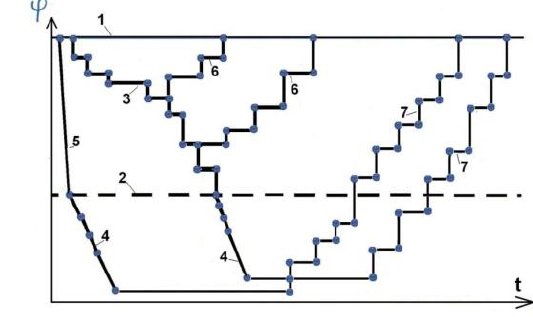
Fig. 3. Illustration for a EPS behavior in terms